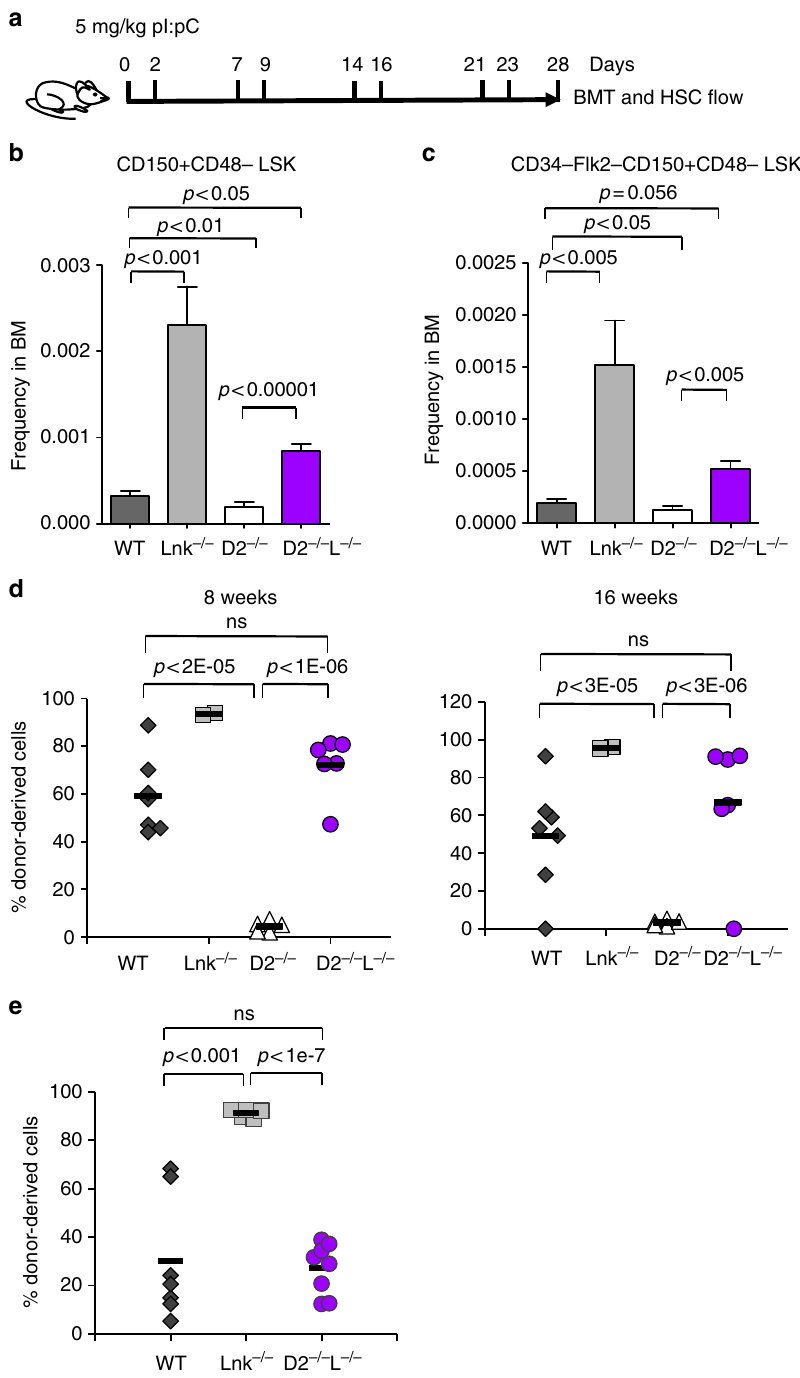
Fig. 5 Lnk de fi ciency rescues HSC defects associated with FA upon forced in vivo proliferation. Proliferation of HSPCs in vivo was induced by pI:pC injection. a depicts a schematic overview of pI:pC injection. Mice were injected i.p. with 5 mg/kg pI:pC twice per week over four weeks, followed by analysis for HSPC frequency and function in bone marrow at day 28. b , c LT-HSC frequency determined by SLAM LSK ( b ) or CD34-Flk2-SLAM LSK ( c ) marker schemes is shown. Bars indicate mean of frequencies from four to six mice, and error bars indicate SE. Statistics were calculated by two-tailed Student ’ s t - test. d Two million total BM cells from pI:pC-treated mice were mixed with 3 × 10 5 competitors and transplanted into lethally irradiated host animals. e In an independent experiment, one million total BM from pI:pC-treated mice were transplanted. d , e Donor chimerisms in peripheral blood of recipients 16 weeks after transplant are shown. Each symbol represents an individual recipient animal, horizontal bars represent the mean of each group. p values from two-tailed Student's t -test are shown. Two independent experiments are